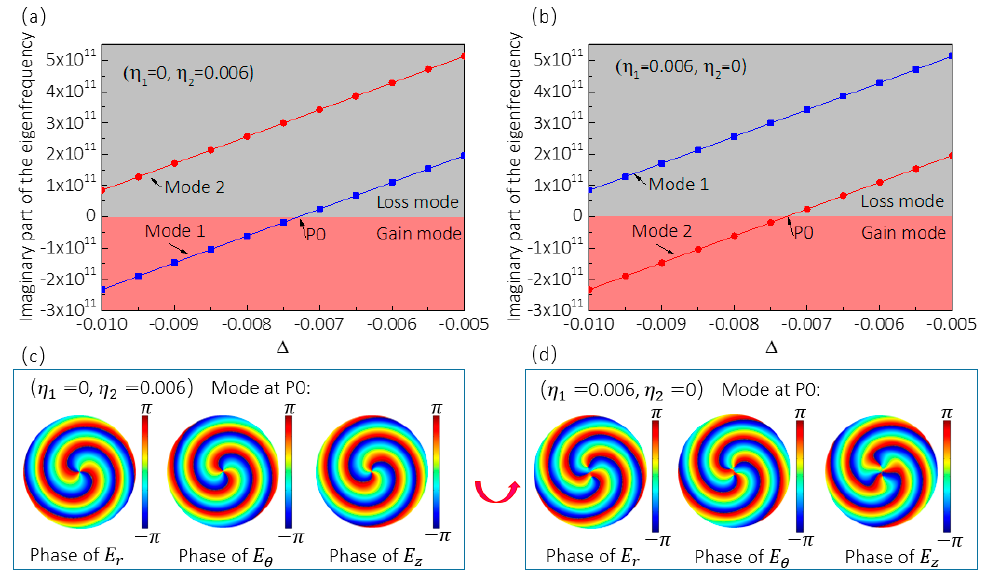
Figure 4. Switching the OAM carried by the emitted light. ( a ), ( b ), The homogeneous background gain dependence of the imaginary part of the eigenfrequencies of modes for the system with parameters ( η 1 = 0, η 2 = 0.006 ) ( a ), and ( η 1 = 0.006, η 2 = 0 ) ( b ). ( c ) The emitted lasing beam corresponding to P0 in ( a ). ( d ) The emitted lasing beam corresponding to P0 in ( b ). The phases of the emission modes in ( c ) and ( d ) are in the cross section (the radius of the area is 5000 nm) of the emission mode at 2 μm above the upper surface of the cavity.